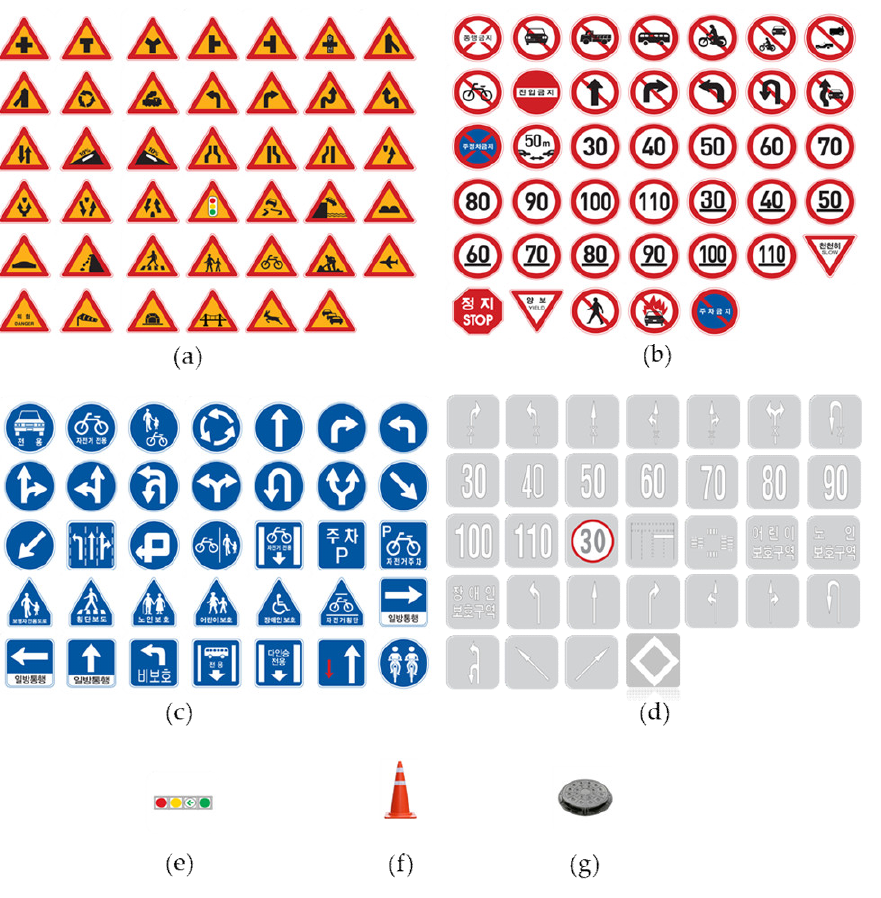
Figure 6. Total of 151 types were selected, including: ( a ) warning signs, ( b ) prohibition signs, ( c ) mandatory signs, ( d ) road markings, ( e ) traffic lights, ( f ) rubber cones, and ( g ) manholes.